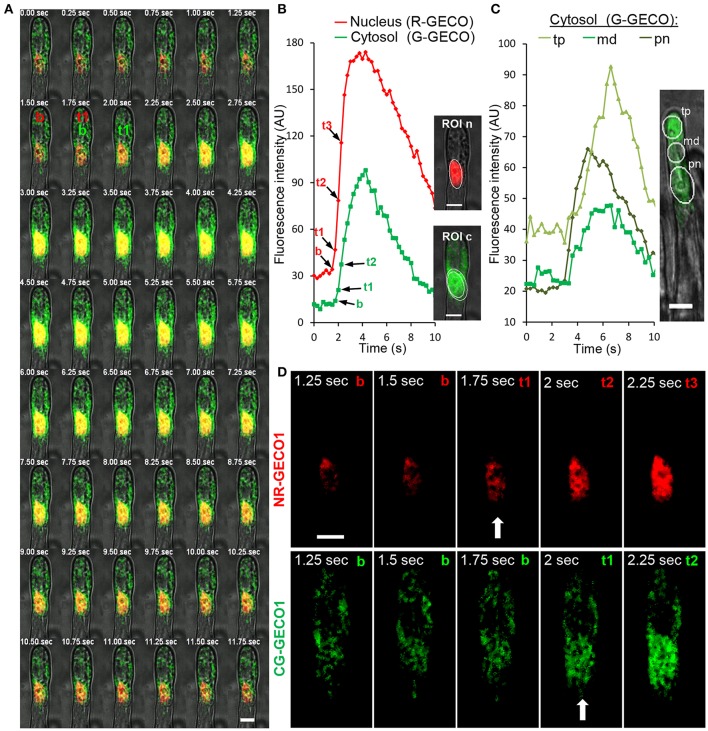
Spatiotemporal dynamics of Ca2+ spiking in nuclear and cytoplasmic compartments of a M. truncatula root hair responding to NFs. (A) A sequential frame-by-frame co-imaging (0.25 s intervals) of nuclear-targeted NR-GECO1 and cytosolic CG-GECO1 revealed coordinated responses during a single Ca2+ spike. (B) Relative fluorescence intensity traces of NR-GECO1 (red) and CG-GECO1 (green) from ROIs selected around the nuclear (ROI n) and perinuclear cytoplasmic (ROI c) regions. Images on the right represent the maximum projection of respective fluorescence images merged with bright field. (C) Relative fluorescence intensity (0.3 s intervals) of CG-GECO1 in selected cytoplasmic regions of interest in the perinuclear (pn), middle (md), or root hair tip (tp) regions during a NF-triggered Ca2+ spike. (D) Close view of selected fluorescence frames shown in (A). Time points representing baseline fluorescence [b in (A,B,D)], the start of the spike [t1 and arrow (A,B,D)], and subsequent spike rise time points [t2 and t3 in (A,B,D)] are indicated for NR-GECO1 and CG-GECO1. Scale bars represent 10 μm.